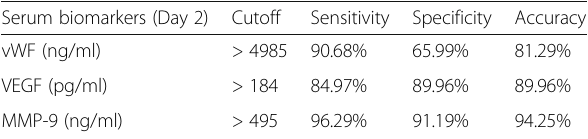
Table 5 Diagnostic performance of serum biomarker concentration in discrimination of CV and non-CV patients Serum biomarkers (Day 2)